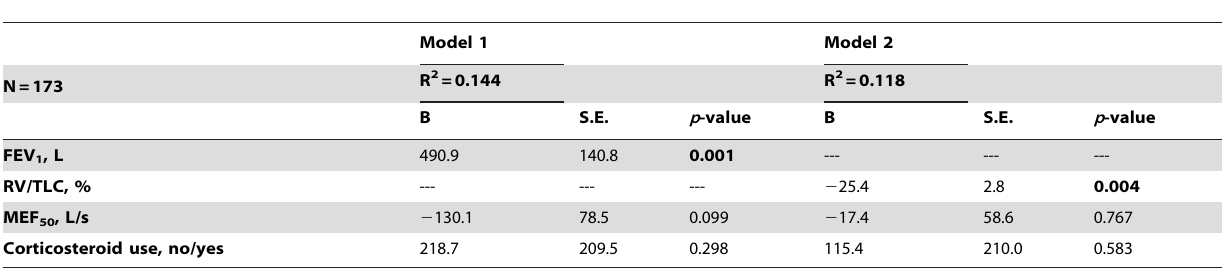
Table 3. Linear regression analyses on skin blanching response (AUC).